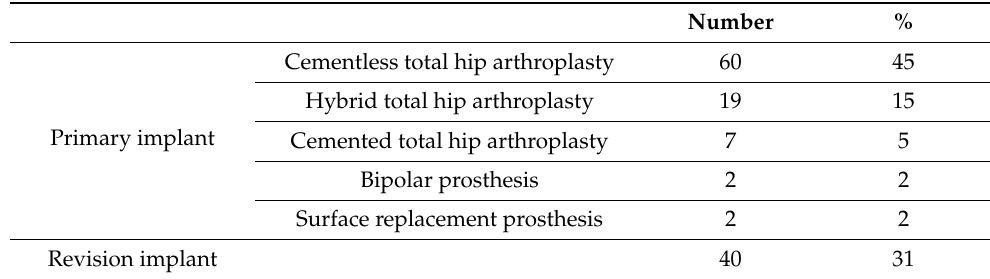
Table 1. Types of explanted